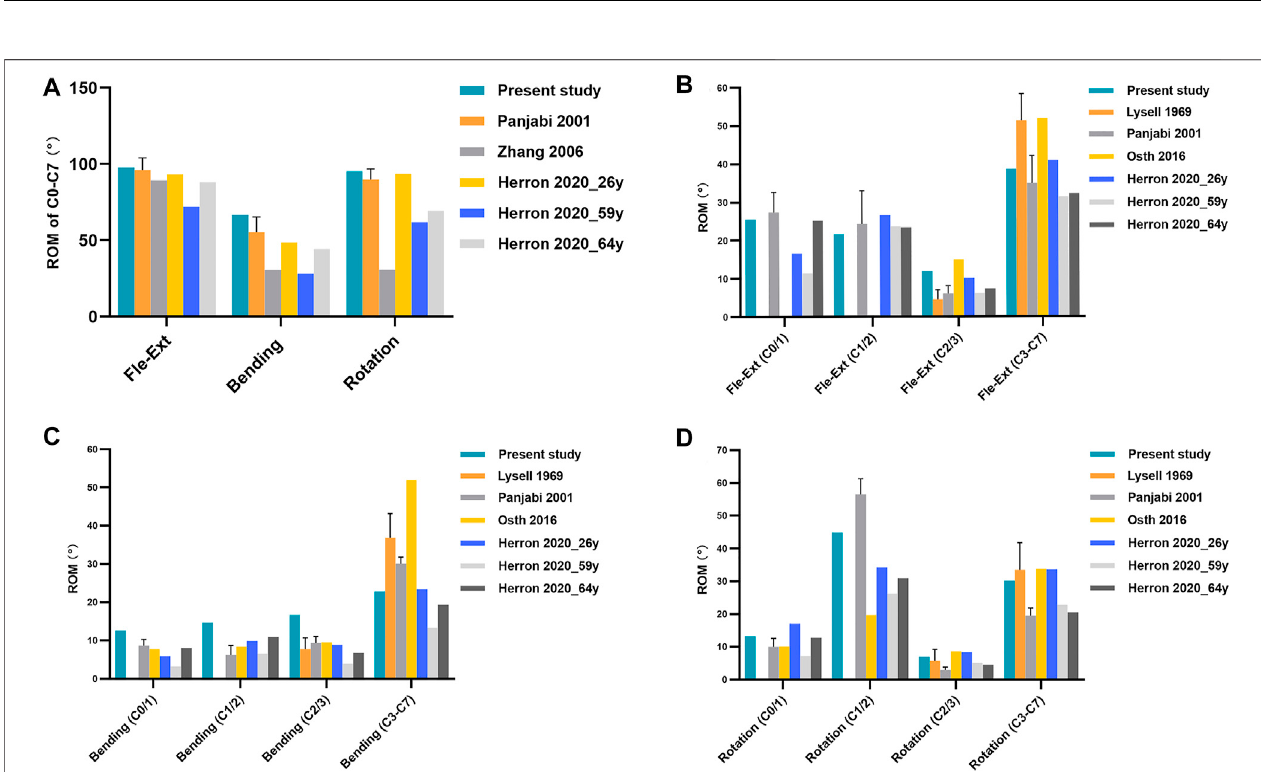
FIGURE3|(A) TotalC0 – C7ROM, (B-D) intervertebralROMoftheuppercervicalspine(C0 – C3)andthetotalROMofthelowercervicalspine(C3 – C7)intheintact model under a 1.0 Nm moment were compared with those of the previously published studies. Fle-Ext: fl